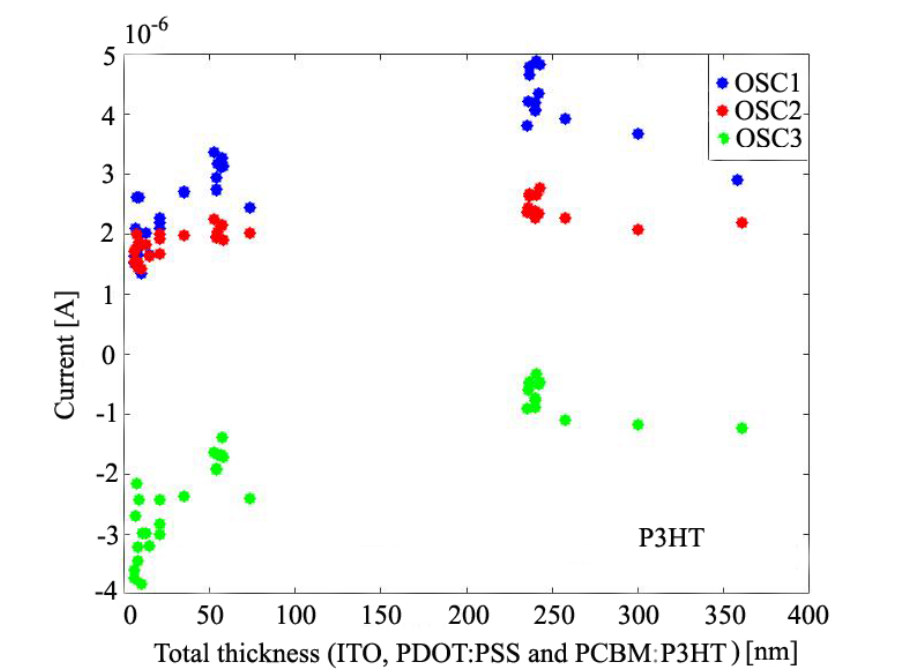
Figure 6. Current as a function of active layer thickness (ITO, PEDOT:PSS, PCBM:P3HT) for three different OSC samples (labeled OSC1, OSC2, and